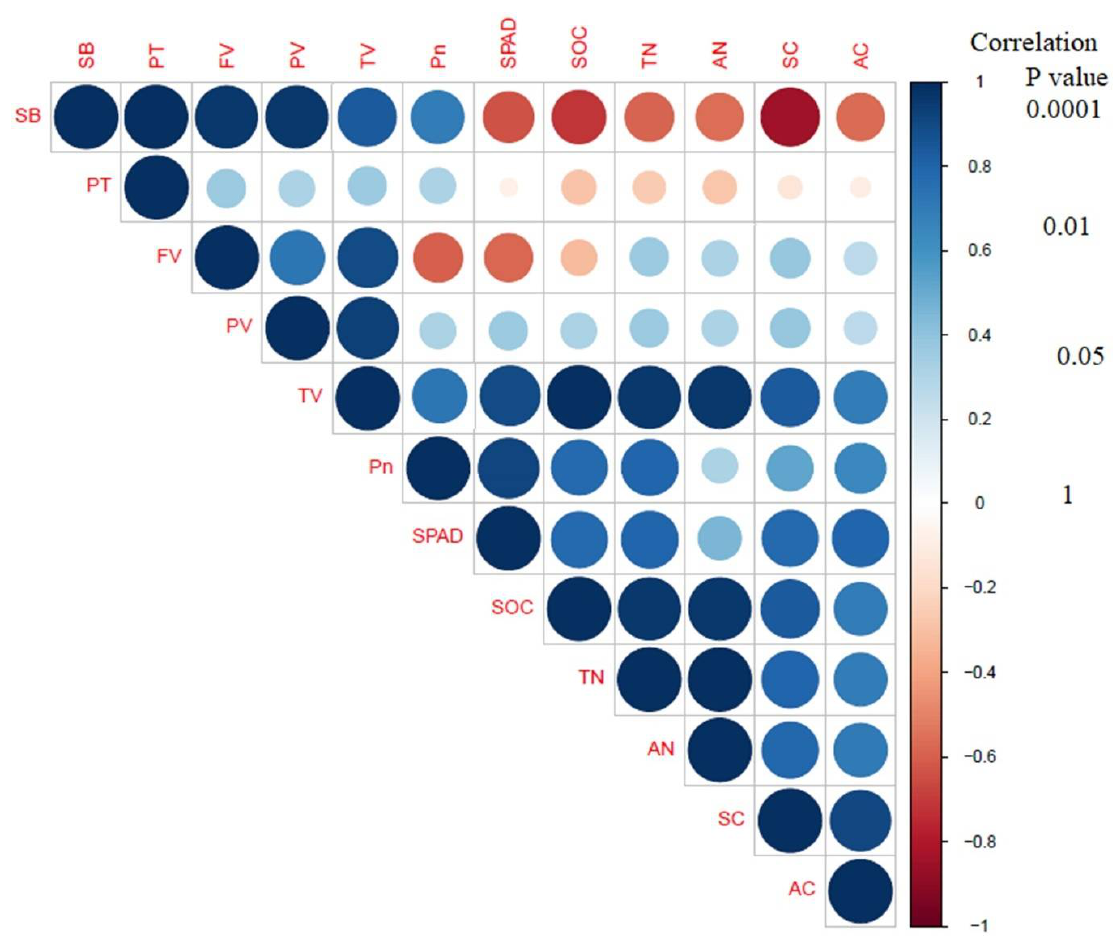
Figure 8. Correlation heat map analysis among the soil chemical properties, leaf physiological traits, and RVA profile characteristics. Note: SOC, soil organic carbon; TN, total nitrogen; AN, available nitrogen; Pn , net photosynthetic rate; PV, peak viscosity; TV, tough viscosity; FV, final viscosity; SB, set back; PT, peak time.